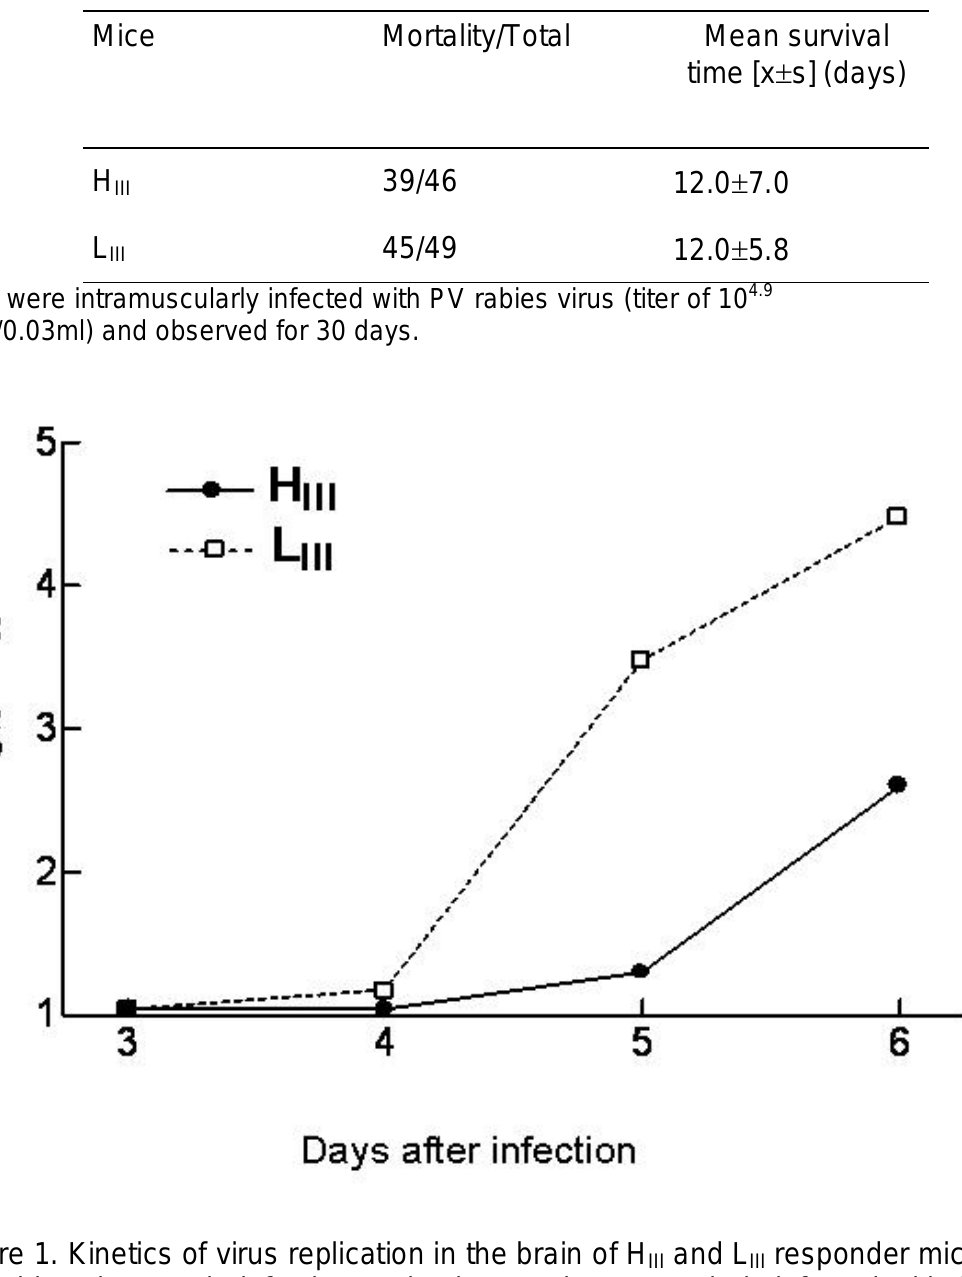
and L responder mice during III III /0.03ml); brains were collected at different moments 50 LD and represented the average of 10 50